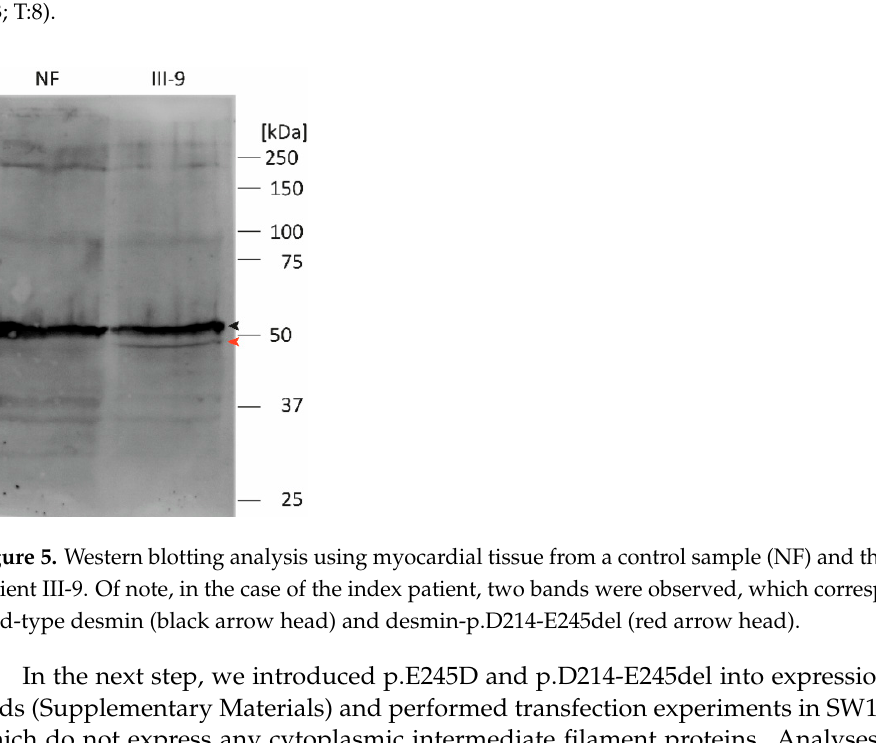
Figure 4. ( A ) Schematic overview of the DES gene. Arrow heads indicate the localization of the oligonucleotides used for amplification. Exons 1 − 9 are shown as blue boxes. Amplicon analysis of a control sample ( B ) and of the index patient III-9 ( C ). In addition to the regular transcript (NM_001927.4), a transcript missing exon-3 was found in III-9 (red arrow) but not in the control sample. Of note, transcripts encoding the missense variant p.E245D were absent in both samples indicating that DES -c.735G>C causes an in-frame exon skipping but not a missense variant in the myocardial tissue from the index